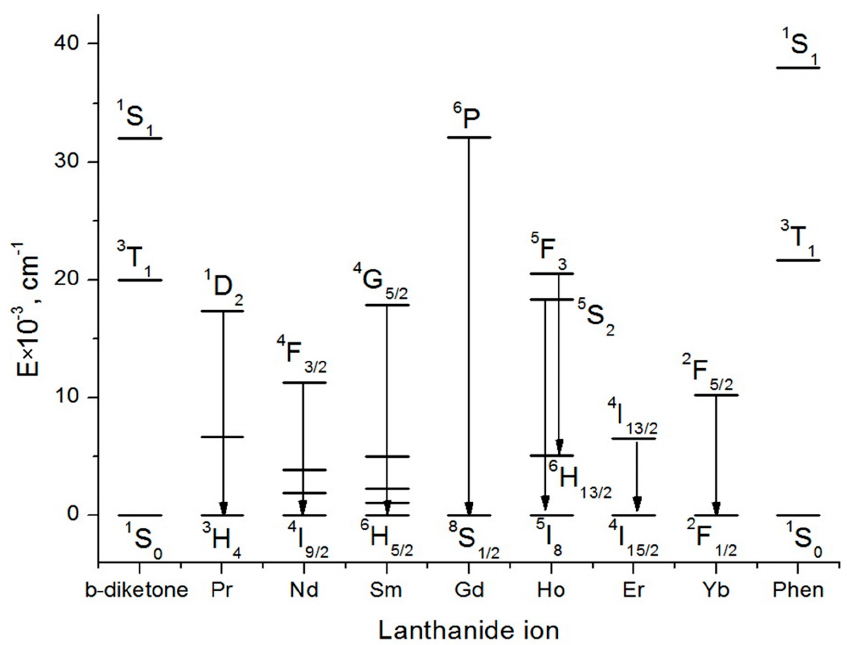
Figure 4. Energy levels of the synthesized